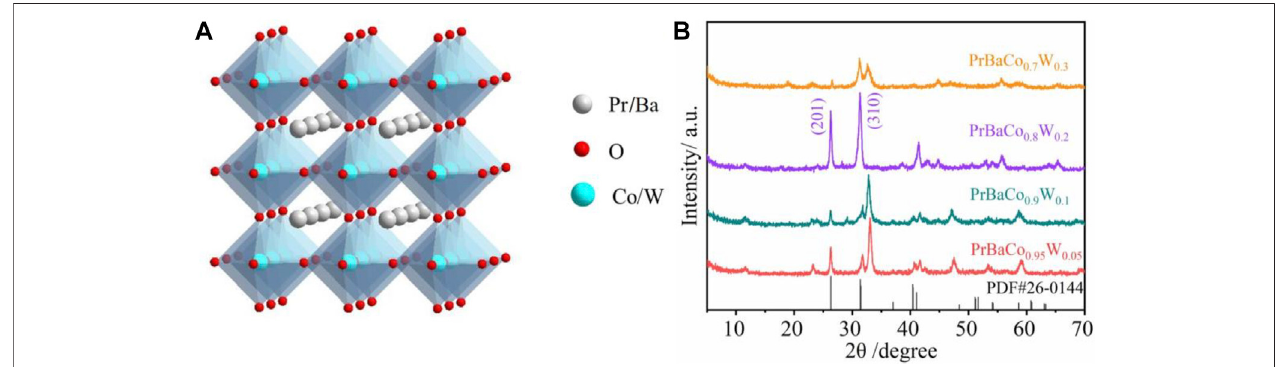
FIGURE 1 | (A) Schematic of the perovskite crystal structure. (B) XRD patterns of PrBaCo 0.95 W 0.05 , PrBaCo 0.9 W 0.1 , PrBaCo 0.8 W 0.2 , and PrBaCo 0.7 W 0.3